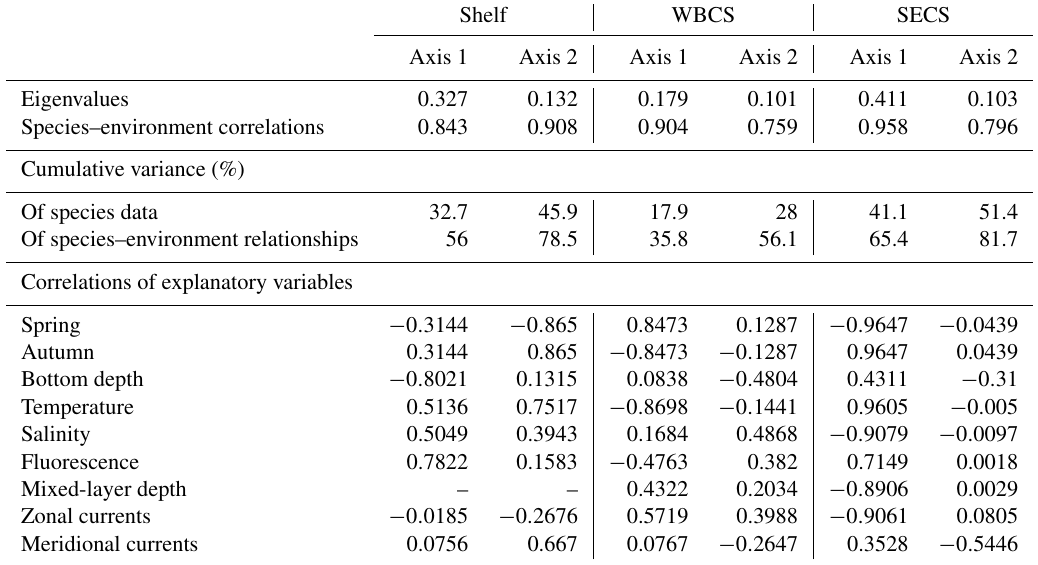
Table 3. Summary of the redundancy analyses (RDAs) performed between the cnidarian community and environmental explanatory variables from the continental shelf, the western boundary current system (WBCS) and the South Equatorial Current System (SECS) in the western tropical South